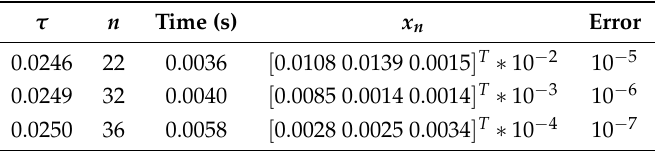
Table 6. x 0 = 10 ∗ rand ( 3,1 ) , results with bounded